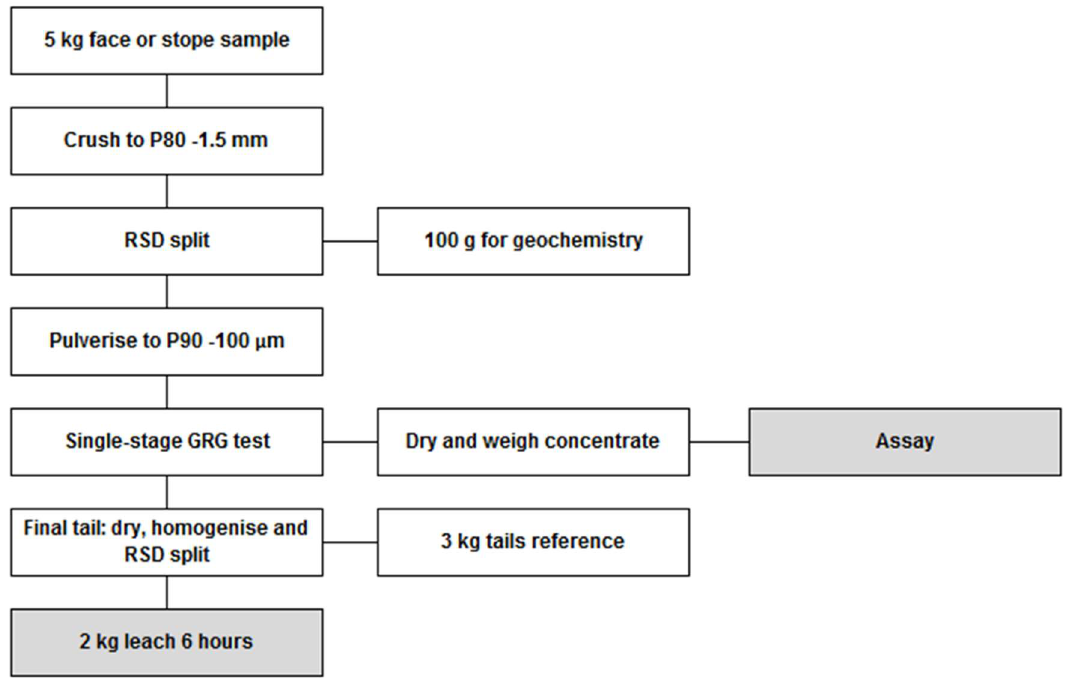
Figure 9. Flow sheet for ore control samples. The GRG test concentrate grade and tails leach grade (grey shaded boxes) are recombined to provide a head grade for the sample.